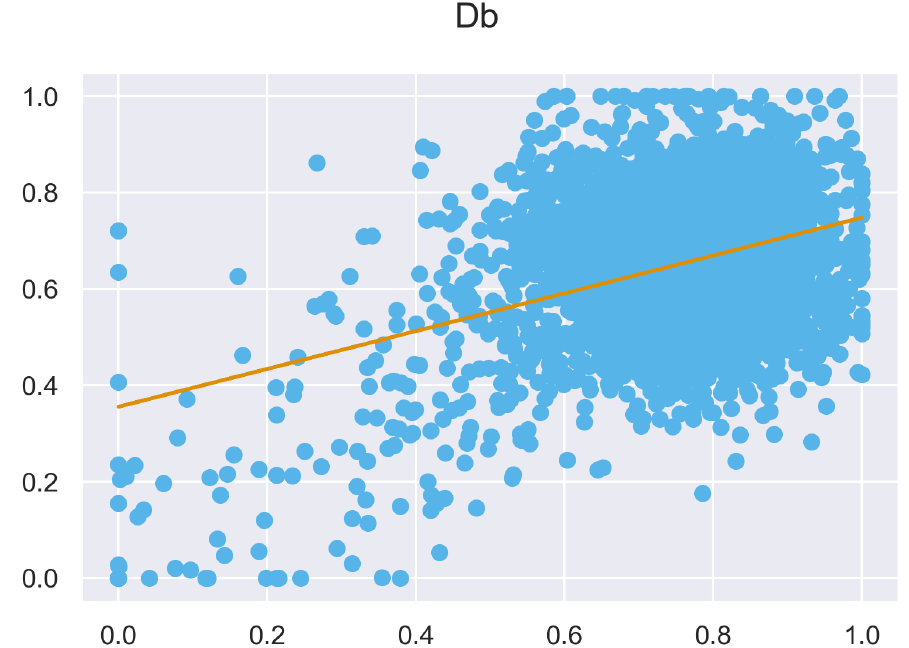
Figure A26. ULS and TLS D b regression at 1m grid size.